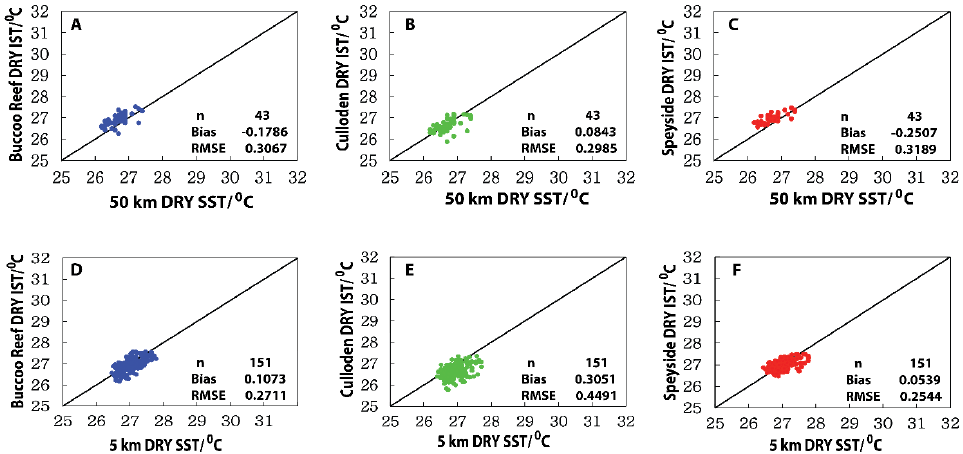
Figure 5. Comparison of 50 km SST ( A – C ) and 5 km SST ( D – F ) with in situ temperature (IST) measurements for the 2014 dry season at Buccoo Reef ( A , D ), Culloden ( B , E ) and Speyside ( C , F ), Tobago. The black line is the line of unity. Positive bias indicates SST greater than IST. Dry season comparisons of 5 km SST showed the satellite values warmer than IST (positive bias) at all three reef sites. Consistency between 5 km SST and IST ( i.e. , the RMSE) was better at Buccoo Reef and Speyside, than at Culloden.